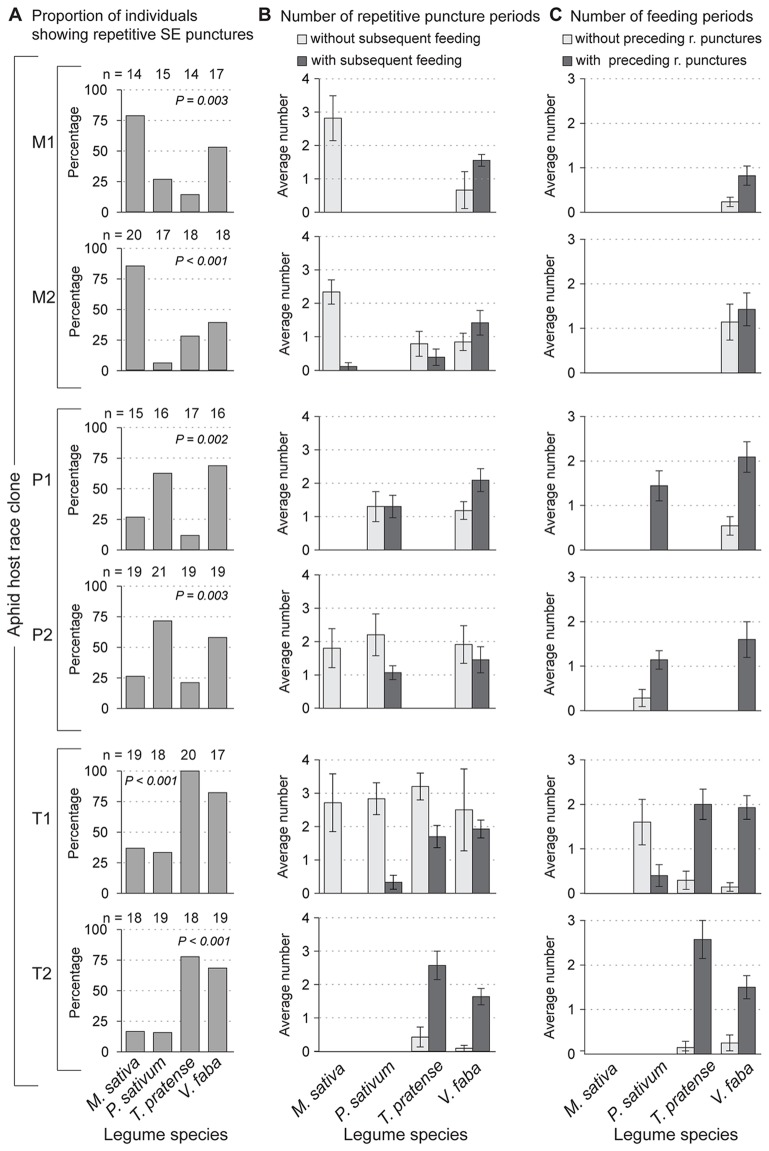
Co-occurrence of repetitive SE punctures and SE feeding.The graph shows the occurrence of repetitive SE punctures and SE feeding for clones (M1, M2, P1, P2, T1 and T2) of each pea aphid host race on the four legume species. A) Percentage of individuals showing repetitive SE punctures throughout the entire experiment (Table 2, parameter #41). B) Mean number +/− std. error of repetitive SE puncture periods per aphid with and without subsequent feeding periods (Table 3). C) Mean number +/− std. error of feeding periods per aphid with and without preceding repetitive SE puncture periods (Table 3). Missing bars in (B) and (C) are due to low replicate number caused by very low observation frequency (< five individuals showing repetitive SE punctures or SE feeding).